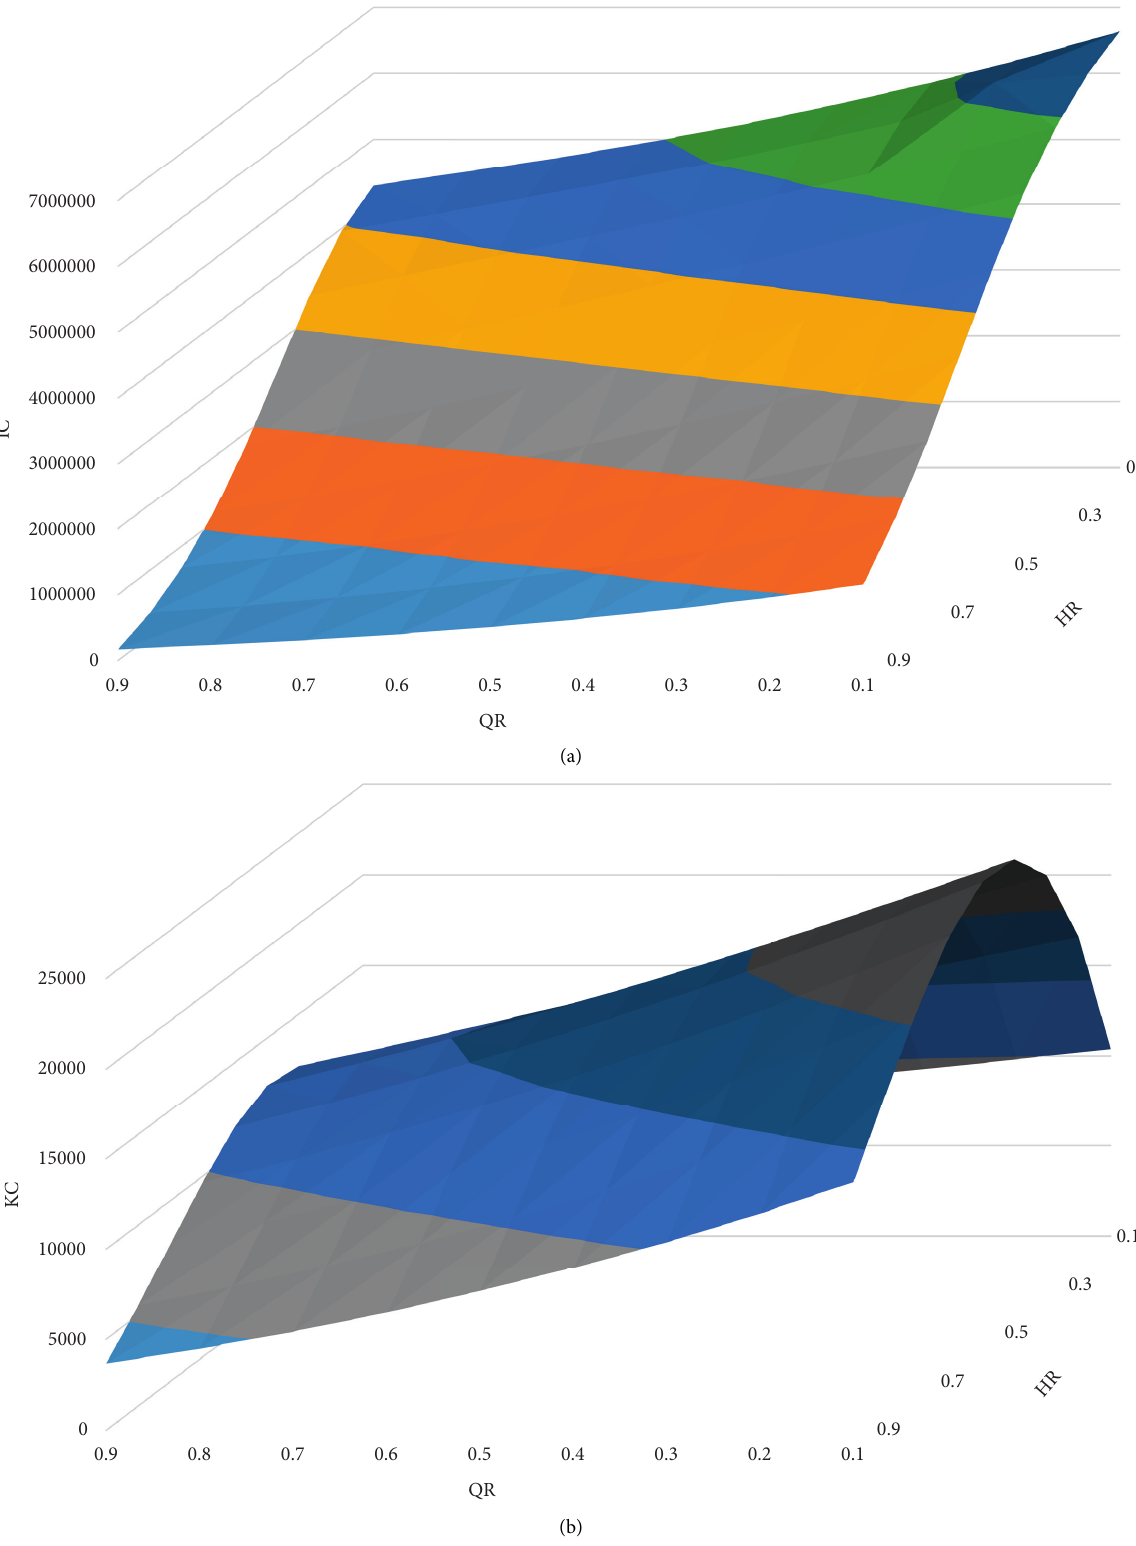
Figure 13: Values of IC and KC under different HRs and